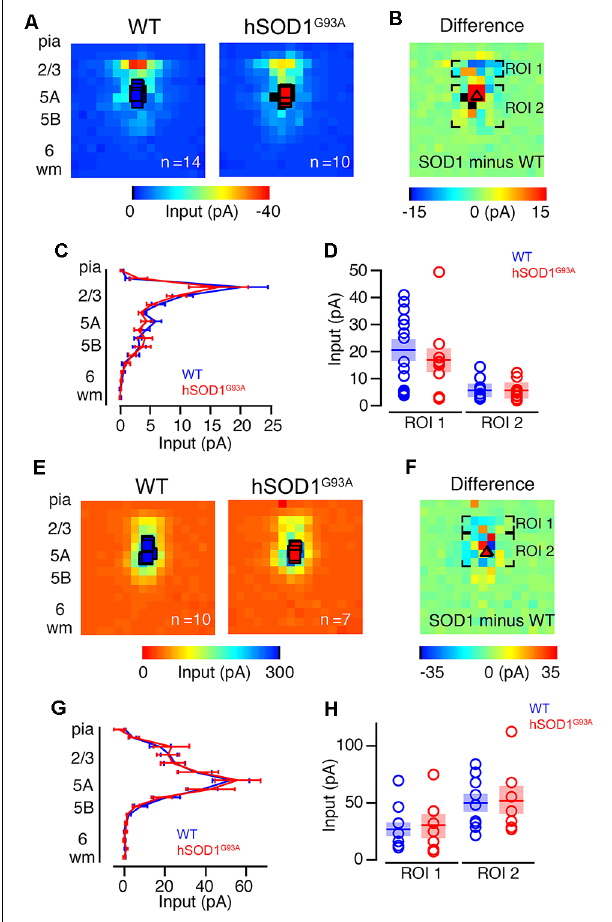
FIGURE 3 | Excitation and inhibitory profiles of callosal projection neuron (CPN) in the motor cortex of WT and hSOD1 G93A mice at P30. Excitatory input maps for CPN of P30 WT and hSOD1 G93A mice. (A) Average excitatory color maps for WT (left) and hSOD1 G93A (right) CPN neurons. Voids represent areas of direct excitation on the recorded neuron. (B) Mapping grid (16 × 16) depicting areas of analysis; Region-of-interest = ROI. (C) Row average of excitatory inputs within the analysis region. (D) Comparison of presynaptic excitatory input region-of-interest for WT and hSOD1 G93A CPN neurons. Inhibitory input maps for CPN of WT and hSOD1 G93A mice at P30. (E) Average inhibitory color maps for WT (left) and hSOD1 G93A (right) CPN. (F) Mapping grid (16 × 16) depicting areas of analysis. (G) Row average of inhibitory inputs within the analysis region. (H) Comparison of inhibitory input region-of-interest for WT and hSOD1 G93A CPN.